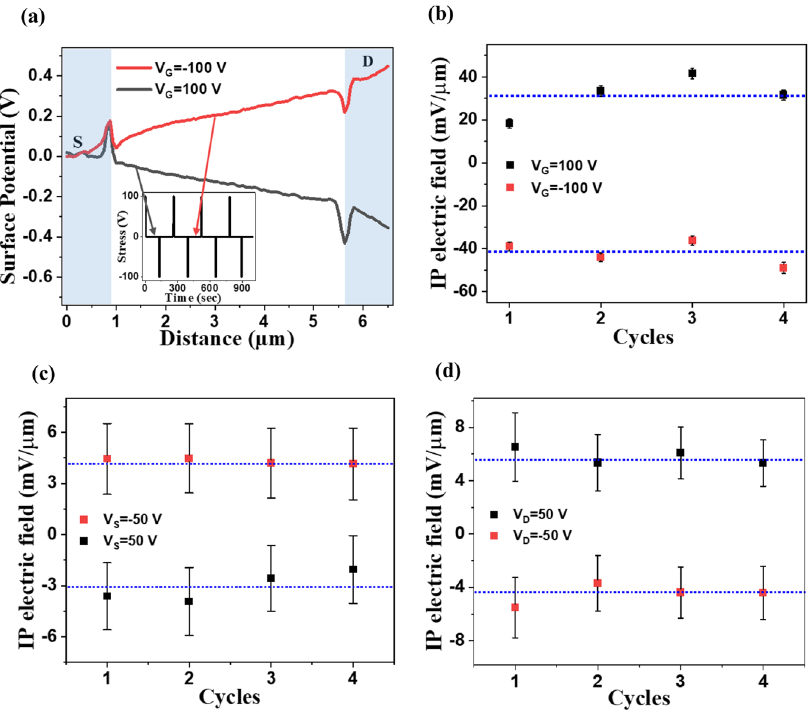
Fig. 3 Bidirectional switching of the IP fi eld. a Potential pro fi les across α -In 2 Se 3 channel following withdrawn + 100 V (gray) and − 100 V (red) gate potential. Inset shows the pulse pro fi le of the applied electrical bias, with the arrows denoting the point of measurement after withdrawal of pulse (pulse duration was 6 s). b Extracted IP electric fi eld across the channel following four cycles of applying alternating gate bias of + 100 V (black squares) and − 100 V (red square). c Extracted IP electric fi eld across the channel following four cycles of applying a bias of + 50 V (black squares) and − 50 V (red squares) on the left electrode (Source) with all other terminals grounded. d Extracted IP electric fi eld across the channel following four cycles of applying a bias of + 50 V (black squares) and − 50 V (red squares) on the right electrode (Drain) with all other terminals grounded. Error bars comprise the standard deviation (STD) analyzed from the full measured pro fi